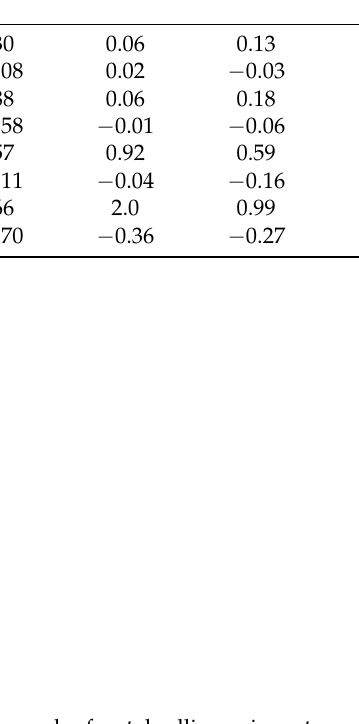
Figure 14. Deformation morphology of the slab corners under frontal rolling using a two-roller with a chamfered length of 20 mm.